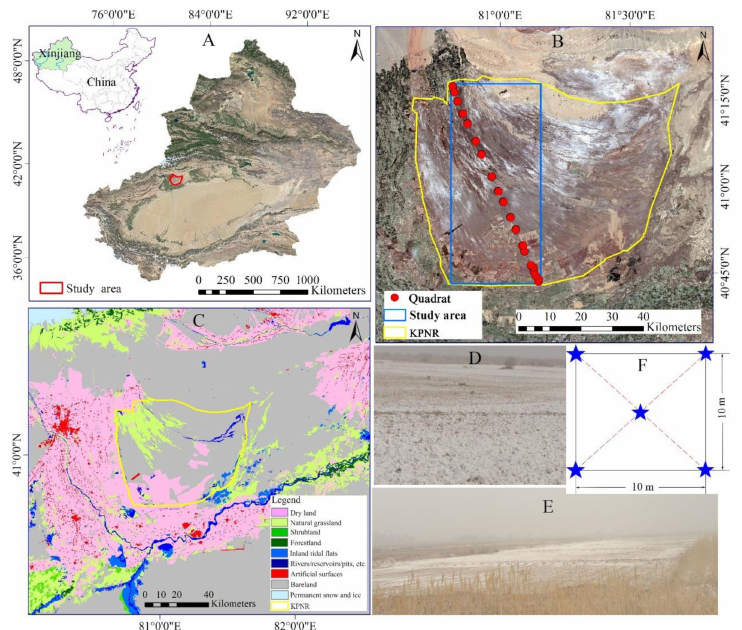
Figure 1. Schematic diagram of the sampling points in the study area. ( A ) Location map of the Kongterik Pasture Nature Reserve (KPNR); ( B ) distribution map of sample quadrat in the study area; ( C ) the present land-use map of the KPNR; ( D ) the native soil salinization landscape in the study area; ( E ) the secondary soil salinization landscape in the study area; ( F ) a schematic diagram of the collection method of mixed soil